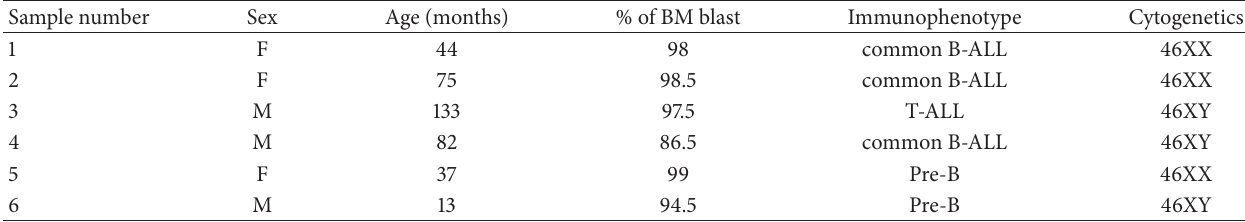
Table 1: The primary characteristics of ALL children at